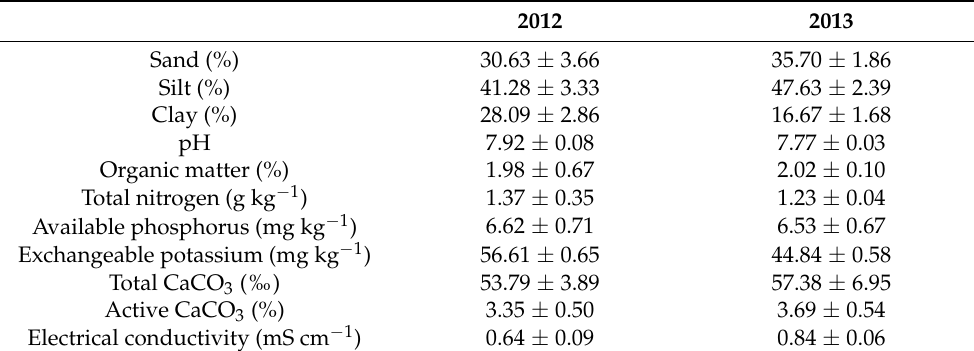
Table 2. Physical and chemical characteristics of the soil at the experimental sites (0–0.3